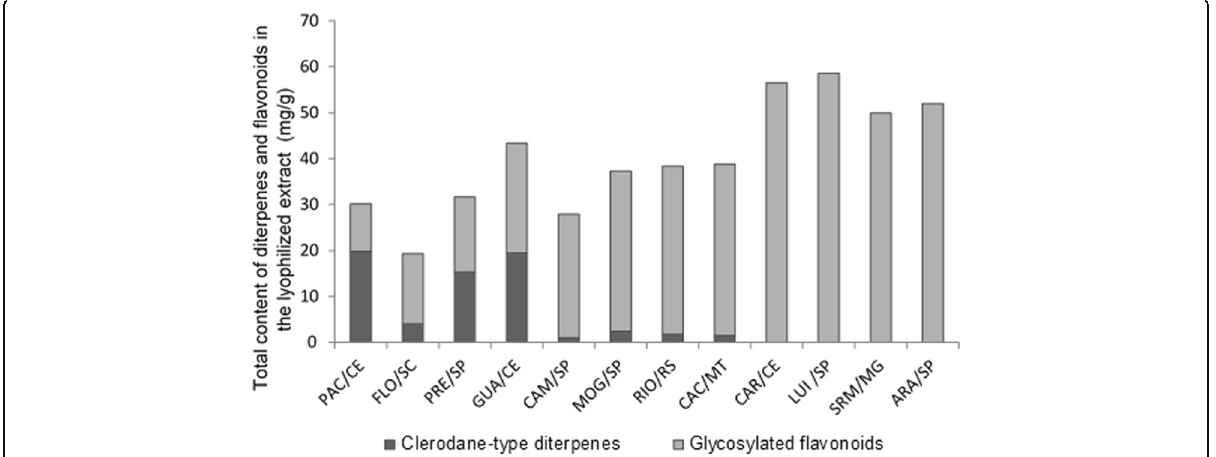
Fig. 1 Quantity of clerodane-type diterpenes and glycosylated flavonoids in C. sylvestris extracts from Brazilian biomes. The letters S , I and L indicate the varieties sylvestris , intermediate and lingua , respectively. (Personal communication by Dr. Paula Carolina Pires